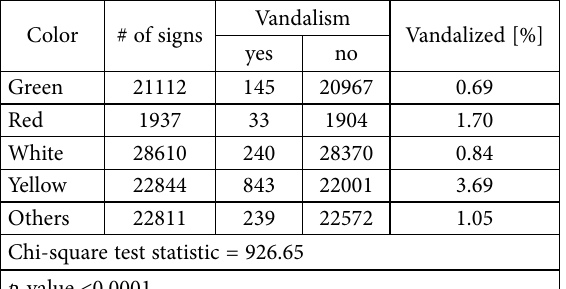
Table 2. Traffic sign vandalism by color